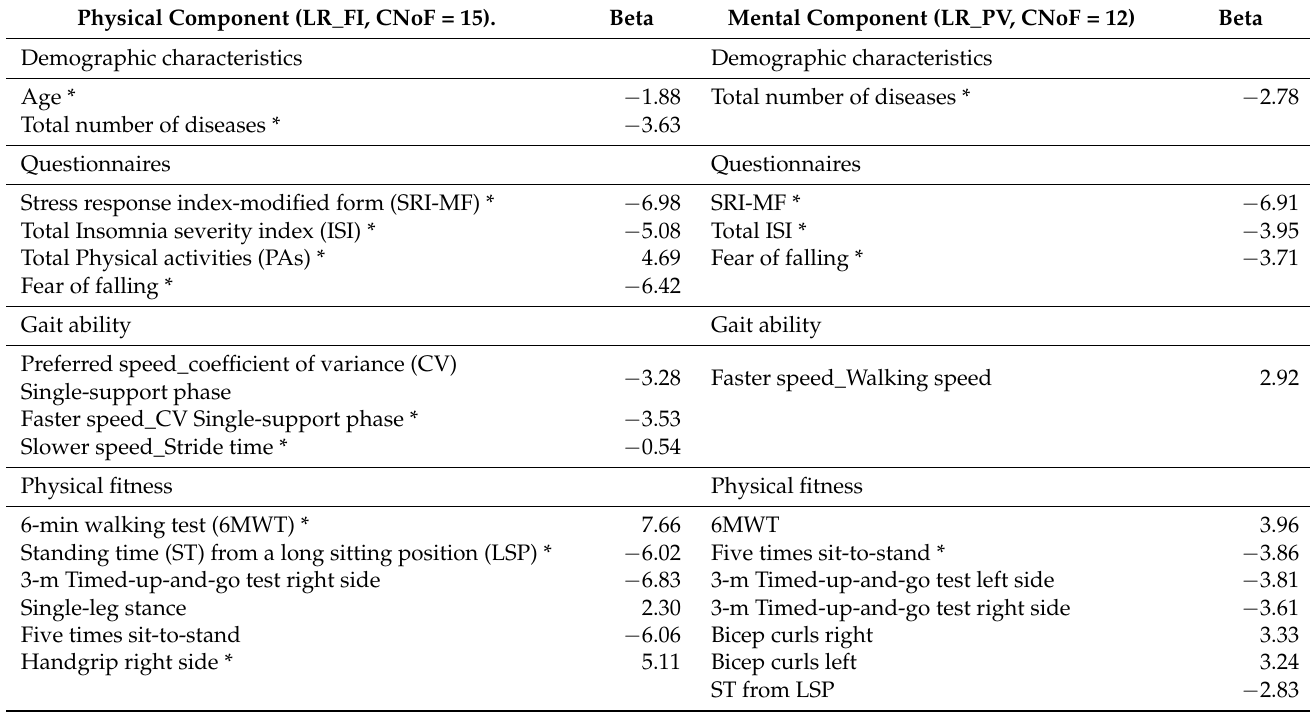
Table 2. Description of beta of features in the best performing